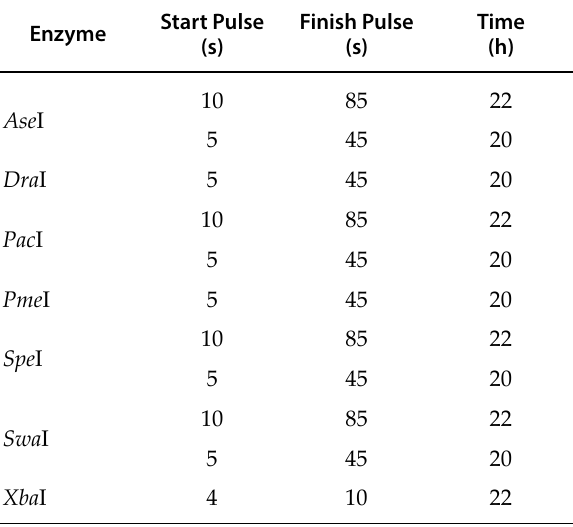
Table 3. Rare-cut restriction endonucleases and working conditions used for PFGE (Voltage: 6 V, temperature: 14ºC,